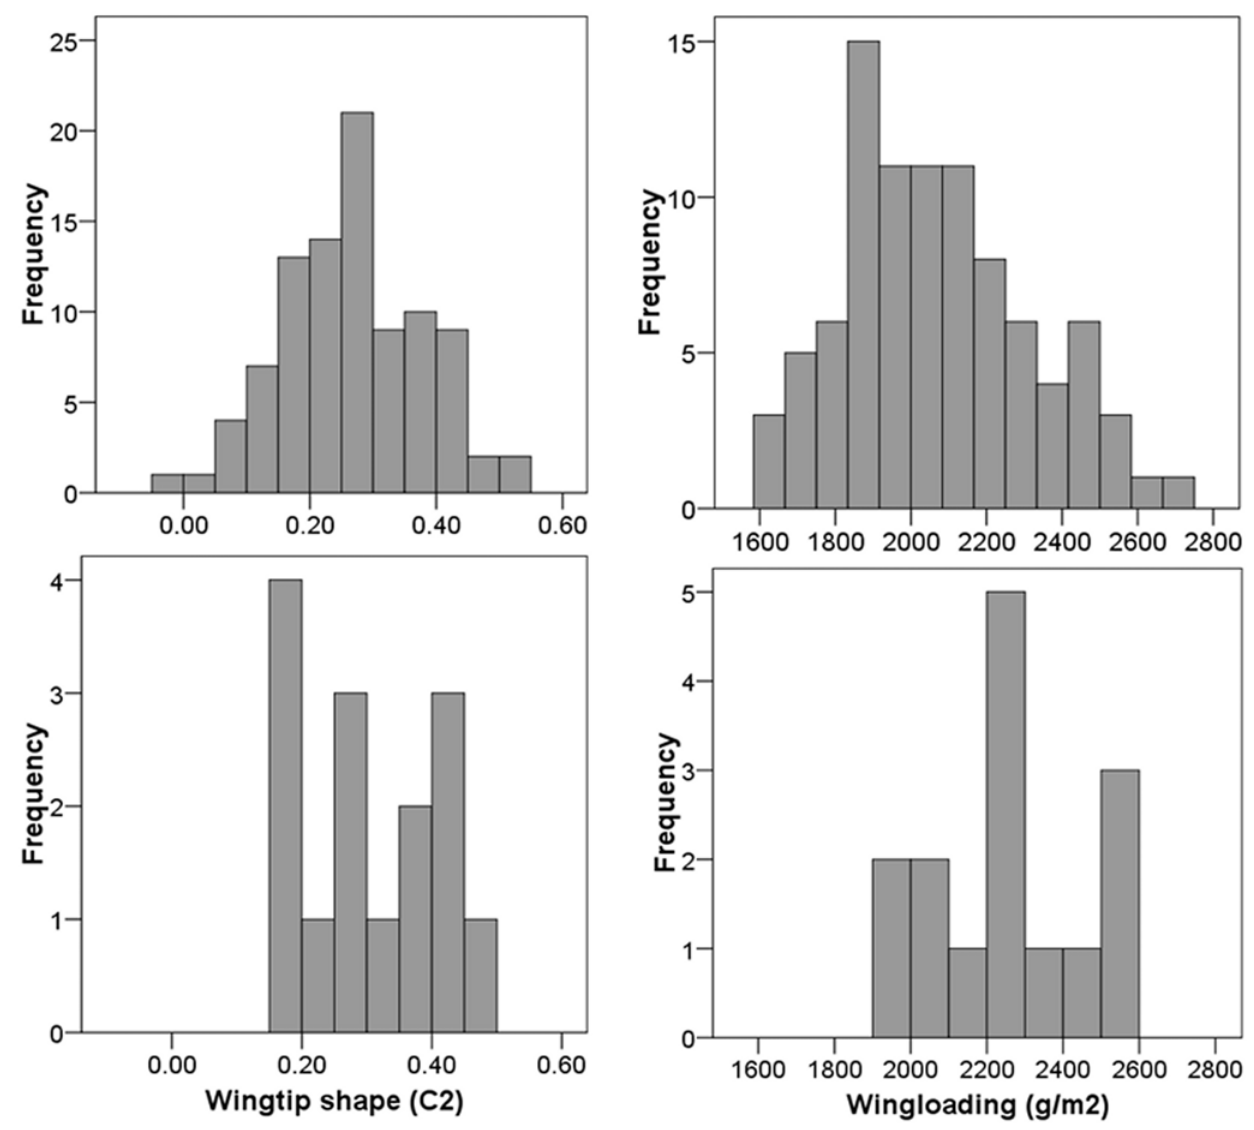
Figure 4. Frequency histograms for wingtip shape (C 2 , lower values indicate more pointed wings [ 3 ] ) and wingloading. The top graphs show the wingtip shapes and wingloadings of 93 Swainson’s Thrushes captured in Champaign-Urbana, IL in May 2003–2005 [25] while the bottom graphs show the same data for the 15 Swainson’s Thrushes followed in this study. Average wingloading is slightly higher in this study than in the larger sample primarily because of the added mass of the